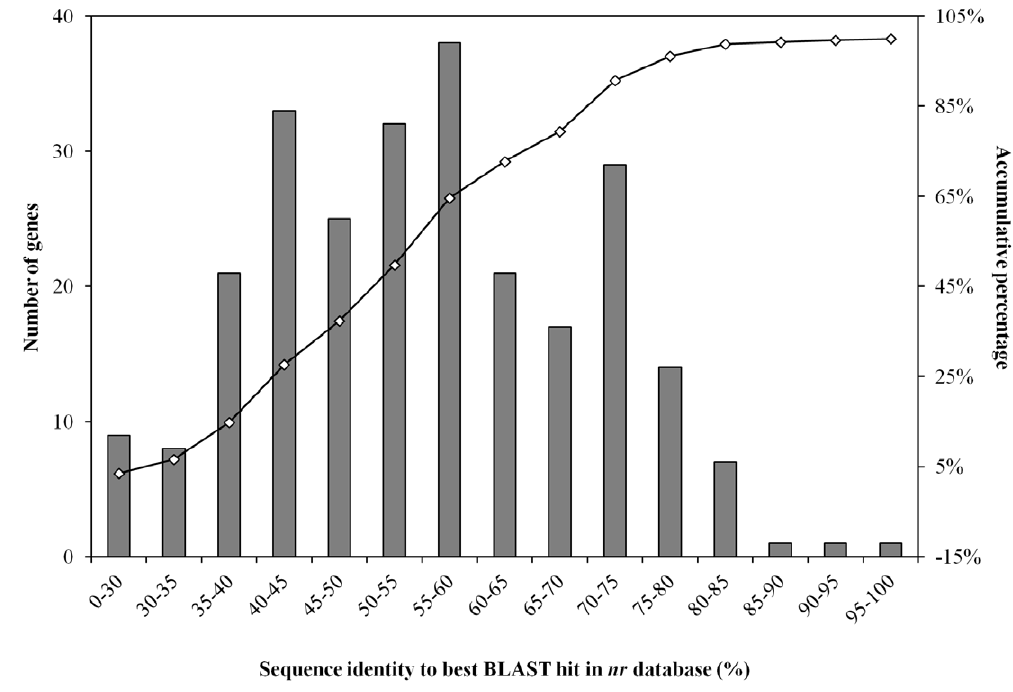
Figure 4. Similarity distribution of predicted ORFs with thermo-stable carbohydrate-active genes against NCBI nr database by BLASTp (E-value # 1E-5).